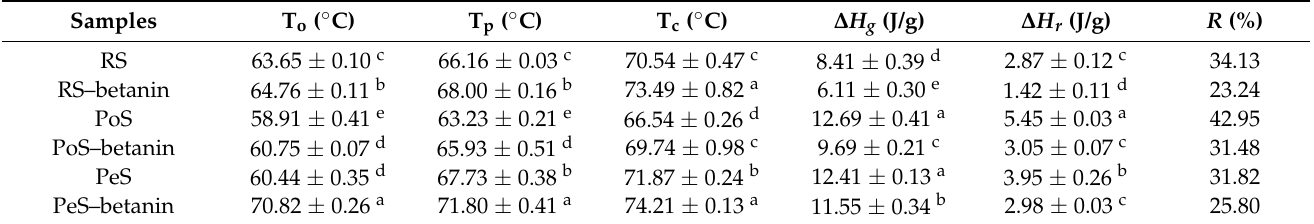
Table 4. Thermal properties of starches and starch–betanin samples after retrogradation for 7 days.